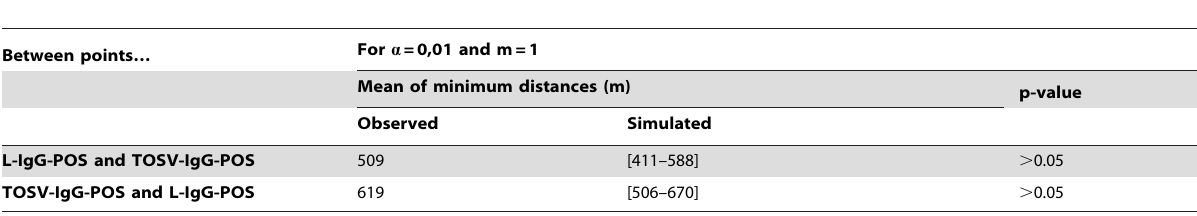
Table 4. Results of the spatial co-location test excluding the intrinsic correlation.